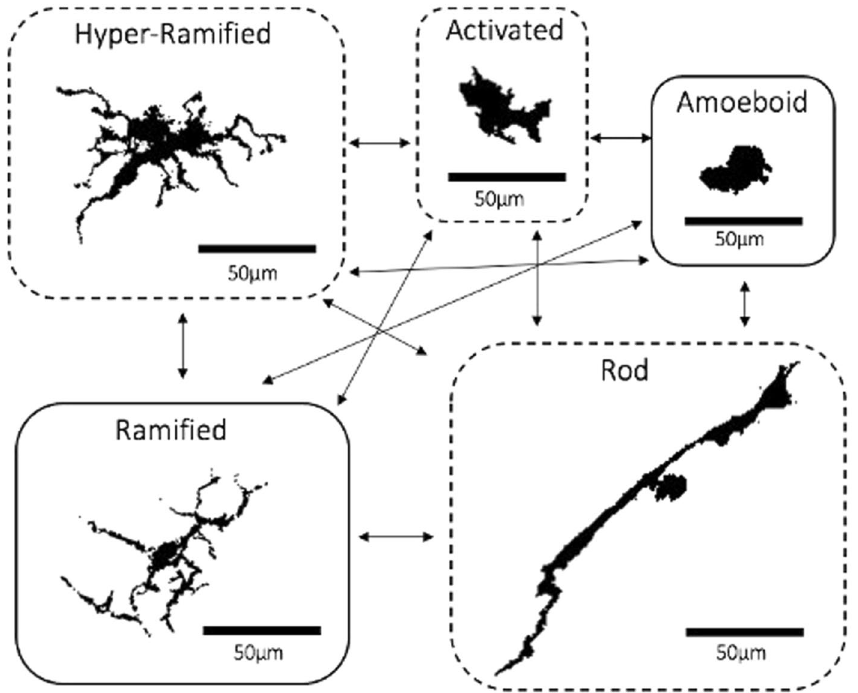
Figure 1. Hypothetical Morphotypes of Microglia. Each microglia morphotype was taken from flat-mounted retinas of C57BL6 mice which were stained with Iba-1 using the staining method in 16 . Diagram taken from 8 . The morphotypes in dashed bubbles (hyper-ramified, activated and rod) may be considered the intermediate states between the ramified and